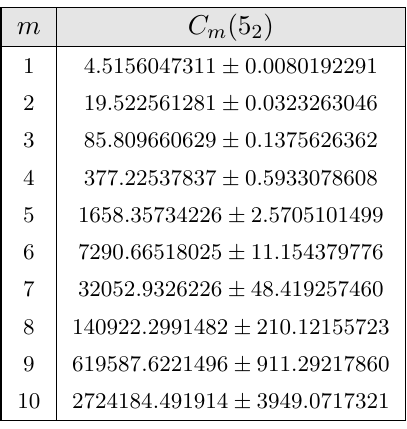
Table 8. Values of C m (5 2 ) . Figure 13. Variation of ln C m (5 2 ) with m .